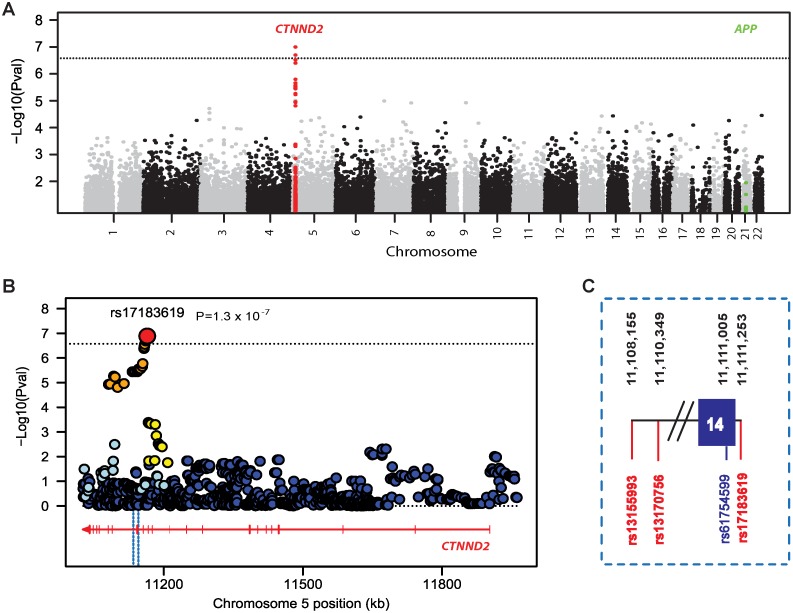
Summary of association results for bivariate analysis of cortical cataract (CC) and temporal horn volume (THV).P-values are expressed as –log10(P) (y-axis) for every tested SNP ordered by chromosomal location (x-axis). Genome-wide significance level is shown as a dotted line at P = 2.6×10−7. Genomic position was determined using the NCBI database (Build 37.1). (A) Manhattan plot showing results for the entire genome. Genotyped and imputed CTNND2 SNPs are indicated with red dots. (B) Regional association plot for the CTNND2 region on chromosome 5 including the top SNP rs17183619 shown by a red circle. Computed estimates of linkage disequilibrium (r2) of SNPs in this region with rs17183619 are shown as orange circles for r2≥0.8, yellow circles for 0.5≤r2<0.8, light blue circles for 0.2≤r2<0.5, and blue circles for r2<0.2. The gene structure and reading frame are shown with the red arrow. Exons are denoted with vertical bars on the arrow. The region demarcated by a light blue dotted box includes the most significant SNPs flanking exon 14. (C) Expanded view of the region in the light blue box. The three genome-wide significant SNPs indicated in red encompass a non-synonymous variant, rs61754599, indicated in blue that is an amino acid change from glycine to arginine at residue 810. Genomic positions of these SNPs are shown at the top of the panel.